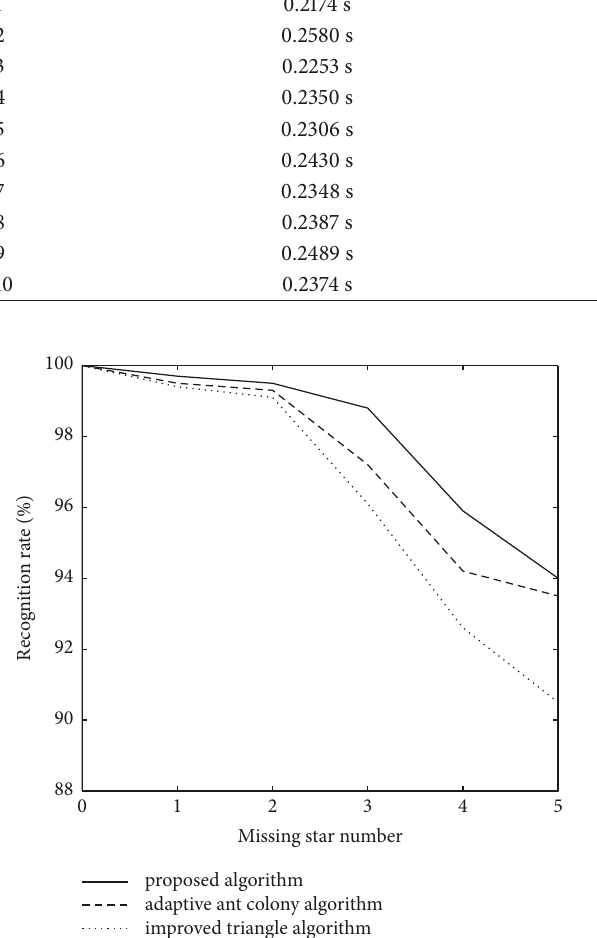
Figure 7: Recognition results under missing star